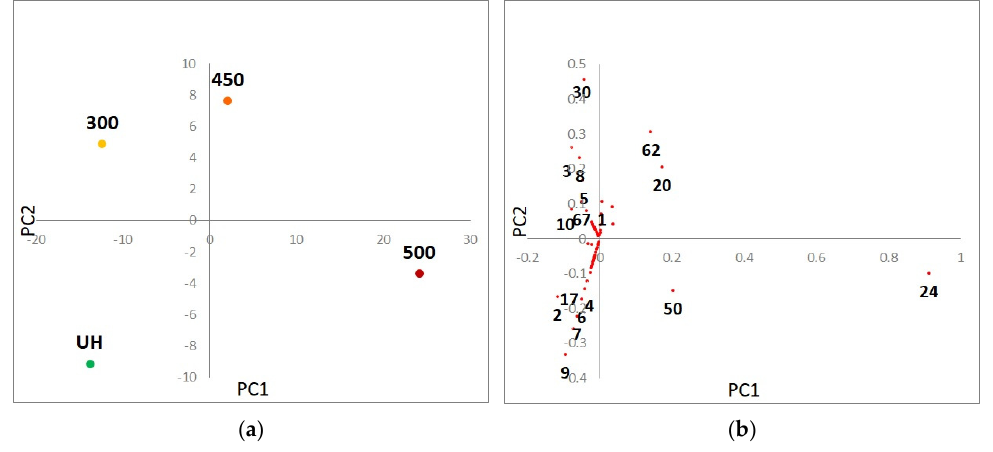
Figure 4. The principal component analysis (PCA) scores plot ( a ) and the corresponding PCA loadings plot ( b ) of the multivariate statistical analysis of the relative abundance of different compounds identified from the soil:water extracts by Pyr-GC/MS. Those compounds significantly related to the separation of different samples have been marked (the numbers refer to the compounds (Cmp) in Table 3) .